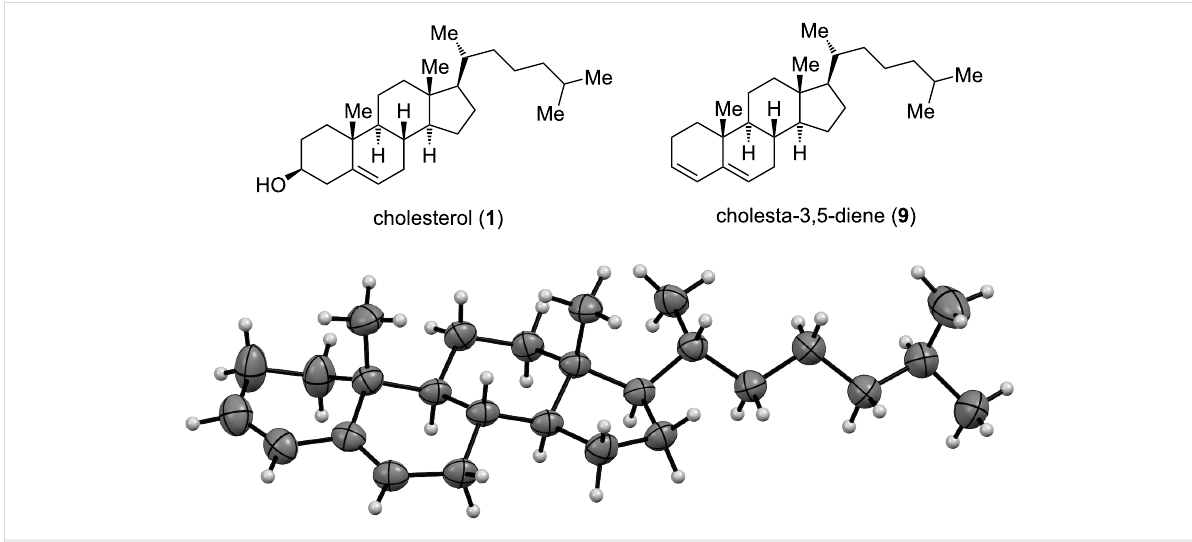
Figure 3: Top: cholesterol ( 1 ) and the less polar product from the Appel reaction, cholesta-3,5-diene ( 9 ); bottom: X-ray structure of 9 with thermal dis- placement parameter at 50% probability level.